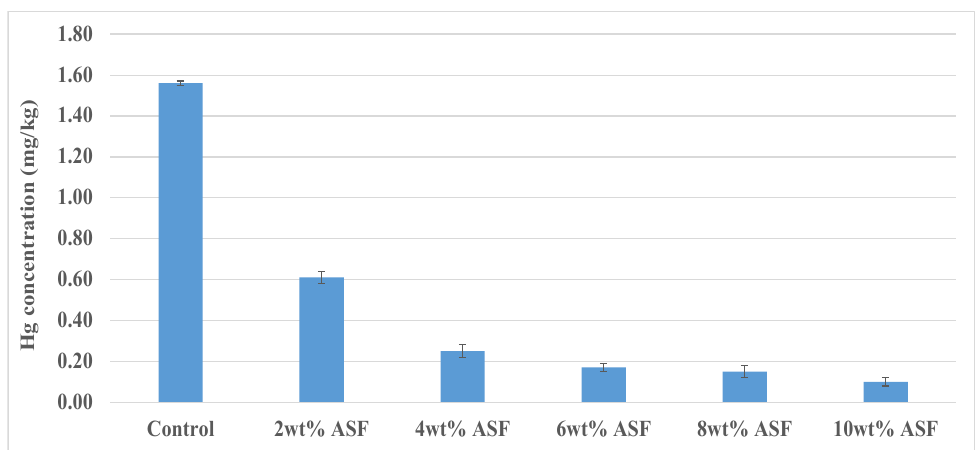
Figure 4. Hg leachability of the control and ASF (-#10 mesh) treated samples after 28d of curing, upon 1N HCl extraction.